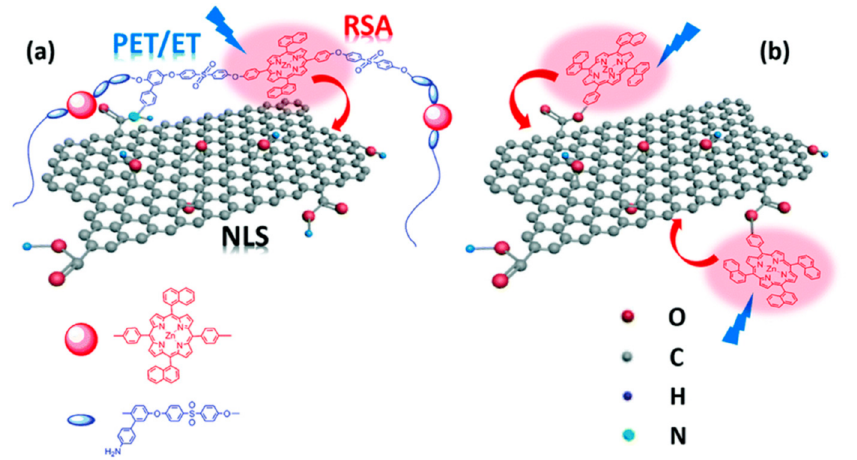
Figure 22. Schematic representation of structures and photoactivity for PF–GO ( a ) and ZnP–GO ( b ). Reproduced from [131] with the permission of the Royal Society of